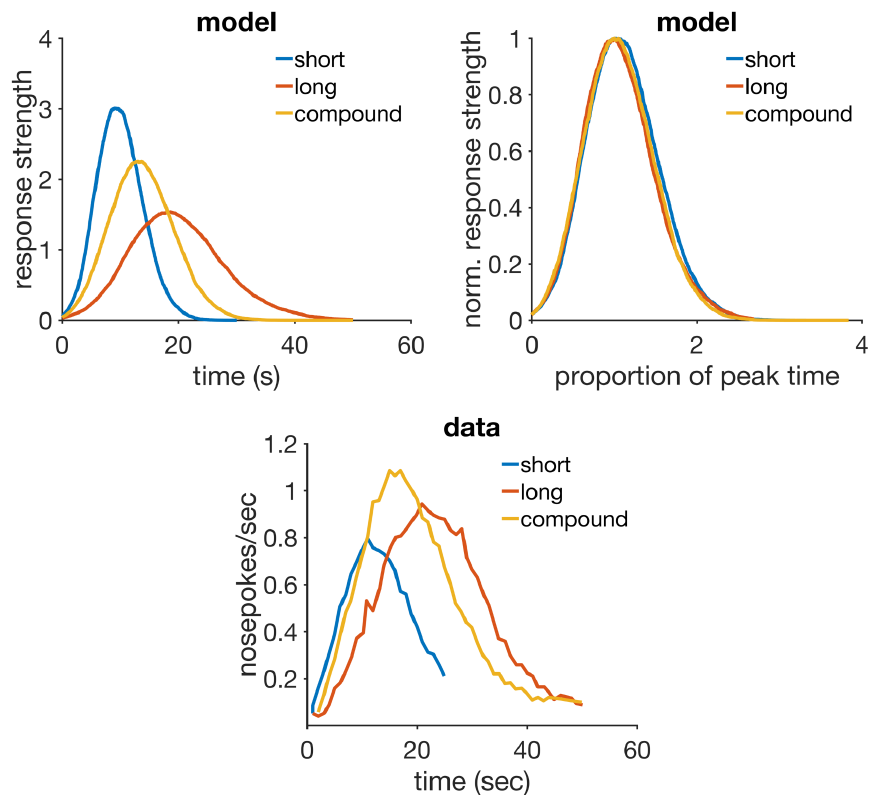
Fig 14. Temporal averaging. Top row: simulatedresponsestrength averagedover peak trials in temporal averaging (left), and the same data normalized by maximum responsestrength and peak time (right). Bottom row: peak trial responsestrength data from an experiment in temporalaveraging,redrawn from Figure 1 in [110]. Model parameters: α t = 0.2, α V = 0.1, μ = 1, σ = 0.35, m = 0.2, H = 30.